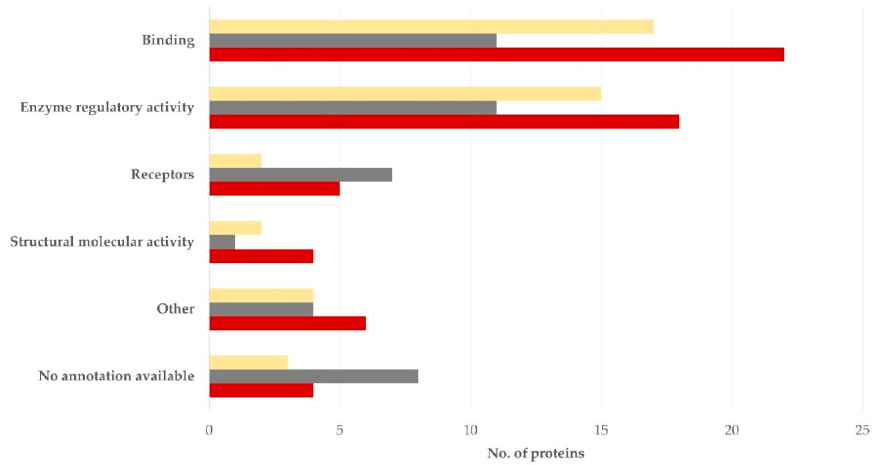
Figure 5. Molecular function of proteins detected in blood plasma (dark red), semen sperm-rich fraction (grey), and semen prostatic fraction (yellow) from dogs were involved (protein identification by LC-MS/MS).